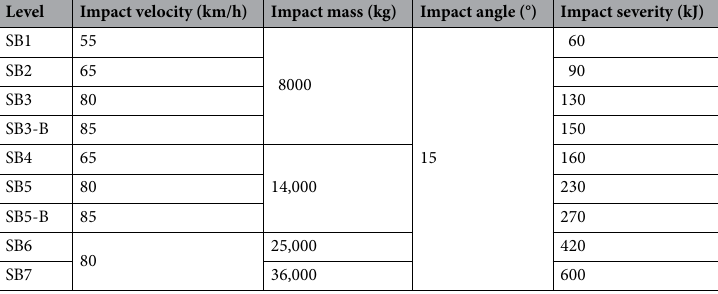
Table 4. The level of impact severity applied to CMBs in Korea 1 .